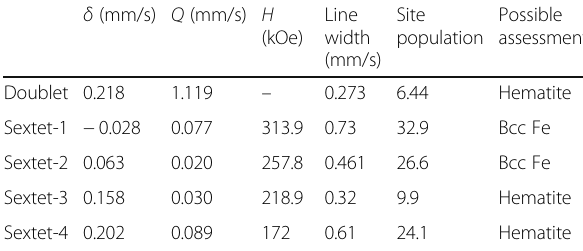
Table 3 Mössbauer parameters, isomer shifts ( δ ), quadrupole splitting ( Q ), and hyperfine field ( H ) of Fe